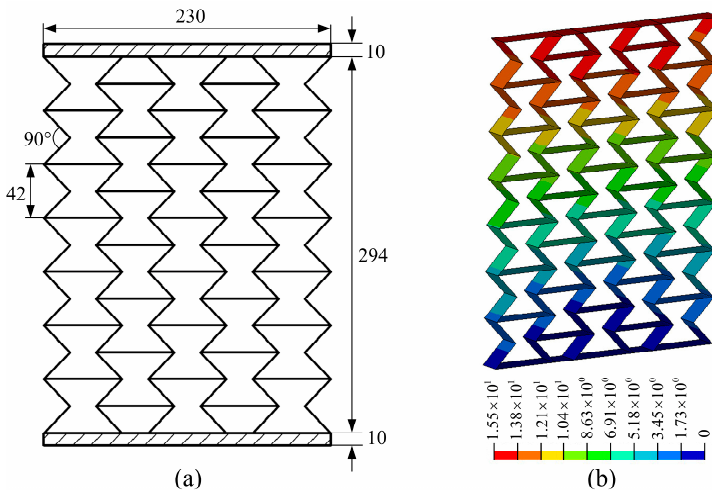
Figure 9. Honeycomb materials in the work by Zhang et al. [43]: ( a ) structural size parameters (unit: mm); ( b ) displacement contour. Table 2. In-plane specific stiffness of metamaterials.